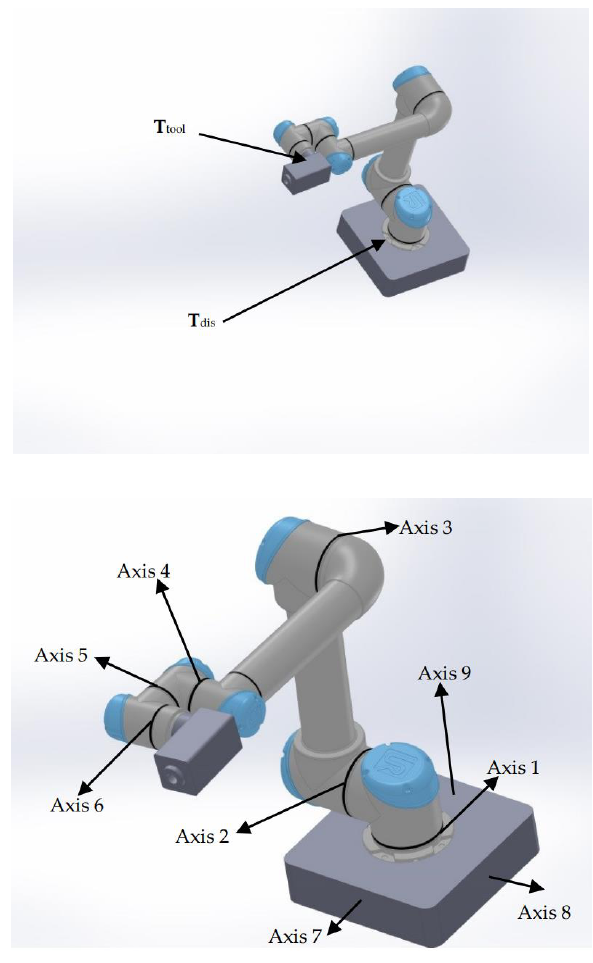
Figure 11. T tool , T dis , and the 9 axes of the UR5 robot system. Figure 12a is the structural diagram of the 6-DOF UR5 robot composed of 6 revolute pairs, represented by 1, 2, 3, 4, 5, and 6, and 0 represents the end fixture of the UR5 robot. In order to analyze the pose change of the UR5 robot ’s end fixture coordinates relative to the end-effector, the D-H model is harnessed to establish the kinematics forward solution model of the UR5 robot.